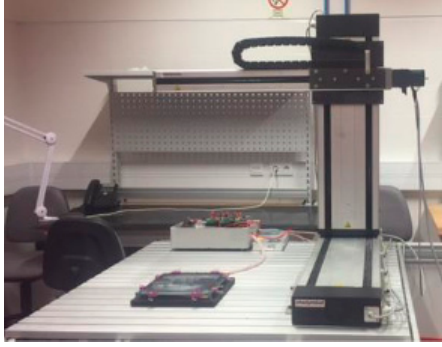
Figure 1. Fused filament fabrication (FFF) prototype equipment.